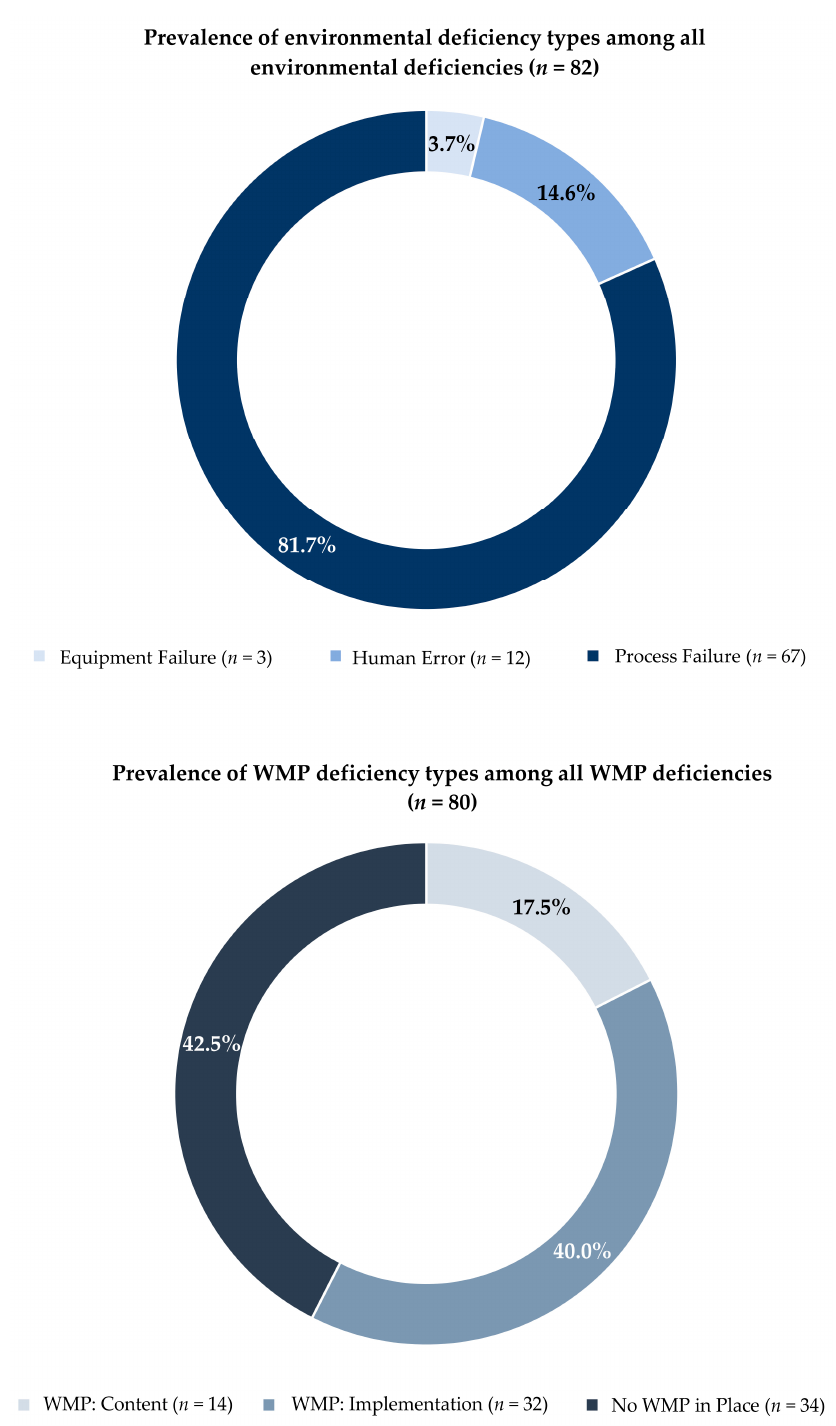
Figure 2. Prevalence of environmental deficiencies and water management program deficiencies, all sites .